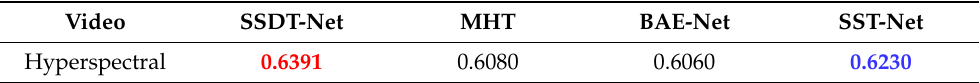
Table 3. Performance comparison with hyperspectral trackers of AUC. Video